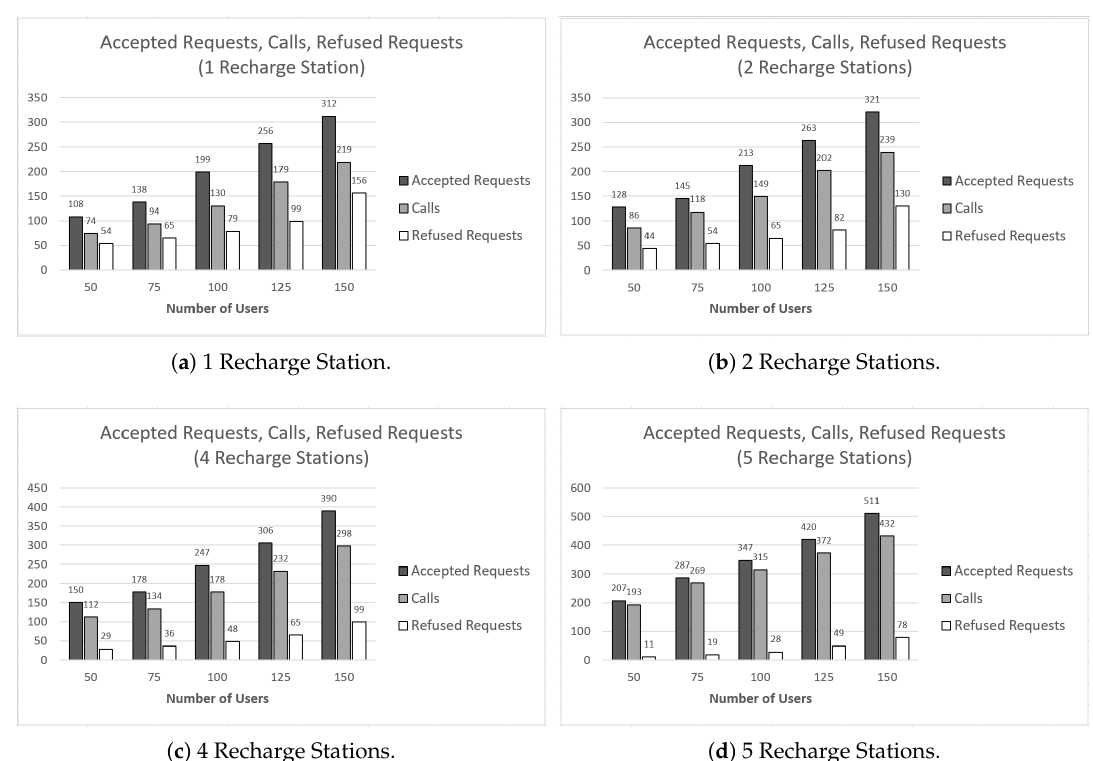
Figure 13. Accepted requests, calls, and refused requests varying users and the recharge stations’ number.